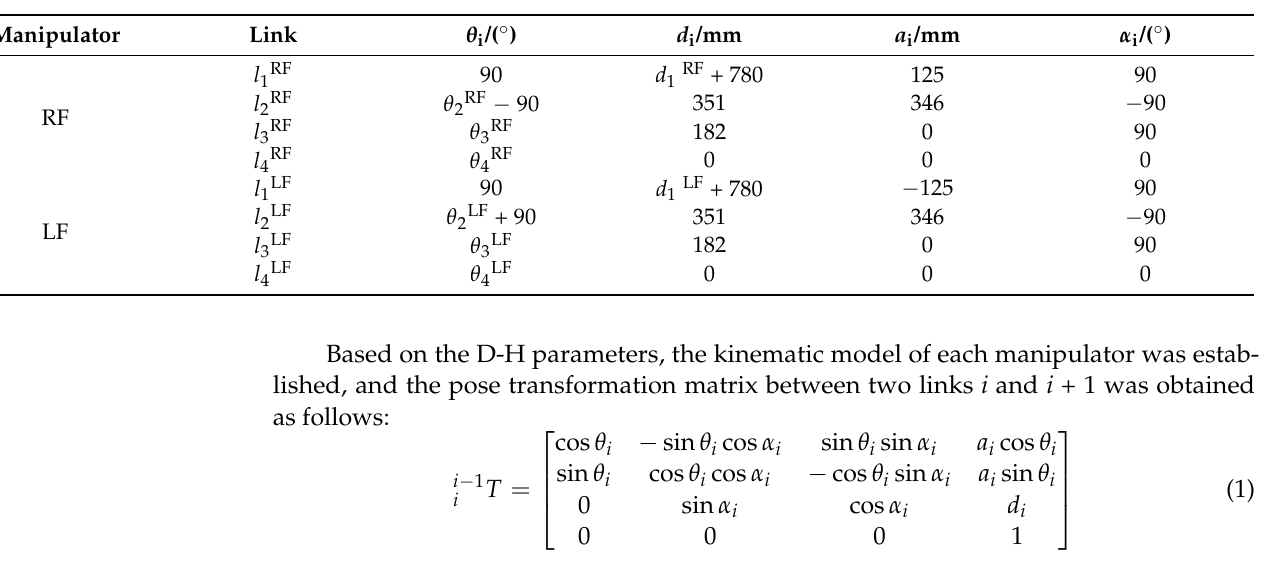
Table 2. D-H parameters of RF and